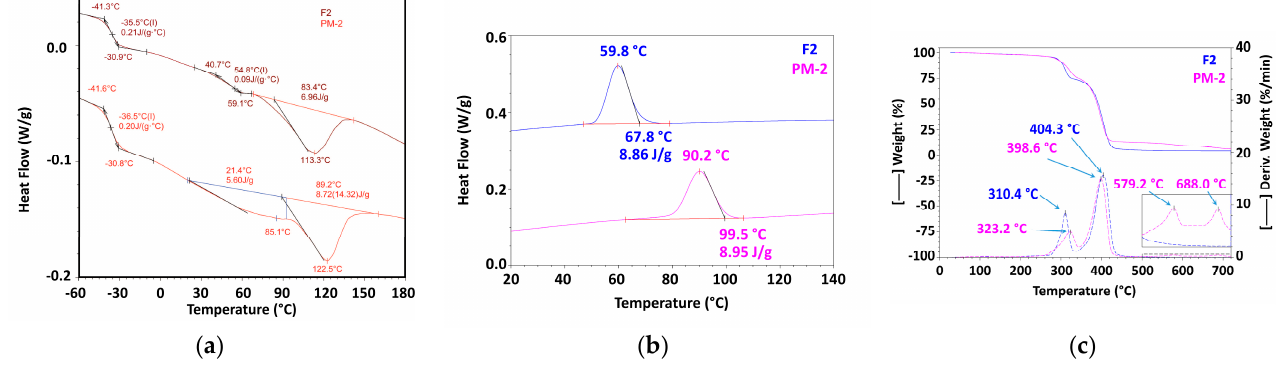
Figure 5. The thermal behavior of mechanically recycled (PM2) and primary compounds (F2) (( a ) melting from second heating run; ( b ) crystallization; ( c )